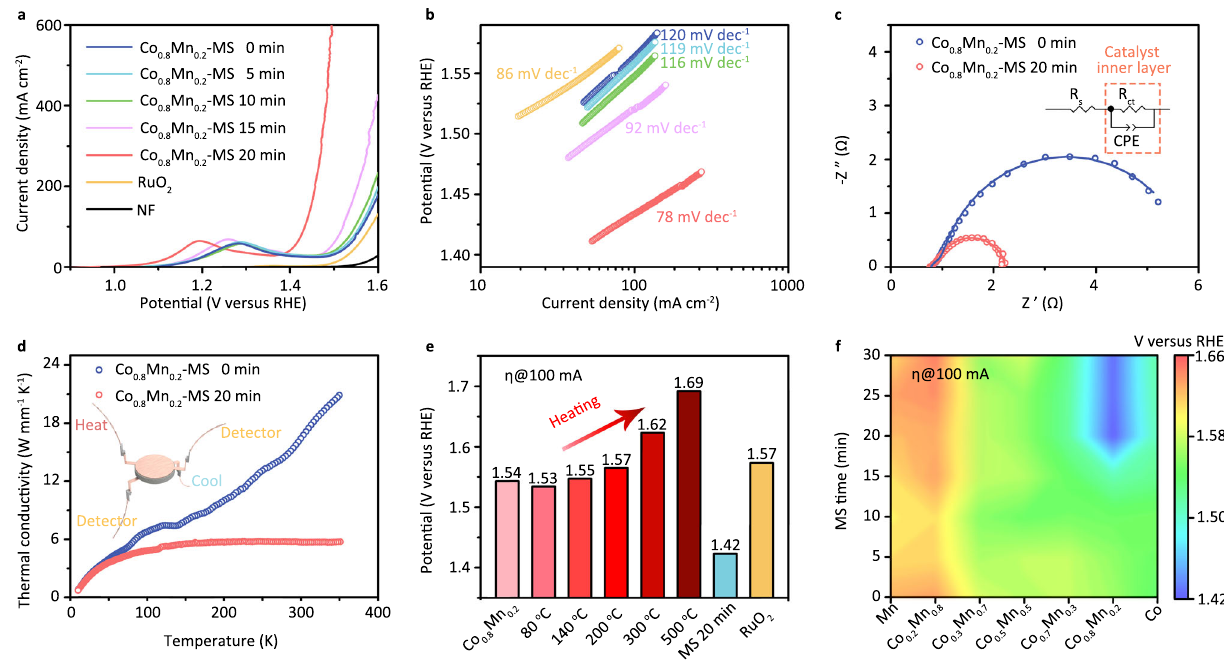
Fig. 4 Practical application of OER. a Polarization curves and b Tafel plots of the Co 0.8 Mn 0.2 -MOF with different times of MS. c EIS curves and d lattice thermal conductivity of the Co 0.8 Mn 0.2 -MOF with and without MS. Inset: the equivalent circuit. e The potential of OER for Co 0.8 Mn 0.2 -MOF at 100mAcm − 2 with different annealing treatment temperature and 20min MS as reference. f The mapping results of the potential at 100 mAcm − 2 for Co x Mn 1-x -MOF with different ratios of Co/Mn and MS